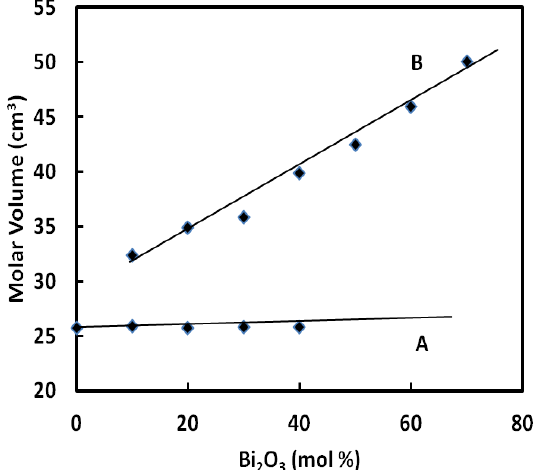
) –(PbO) –( 1/2 Bi O ) (A) and compared with those 2 60 40− x 2 3 x